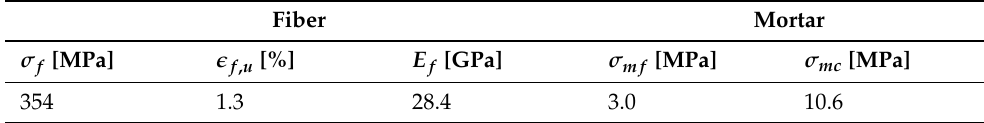
Table 1. Average results for AR glass fiber and mortar NHL5.